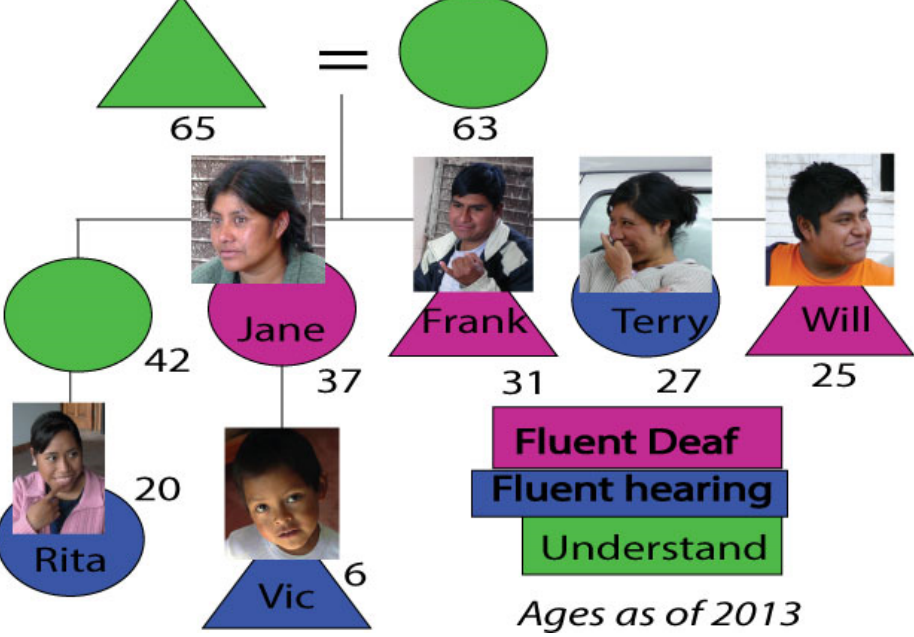
Figure 1. Genealogy of Z family